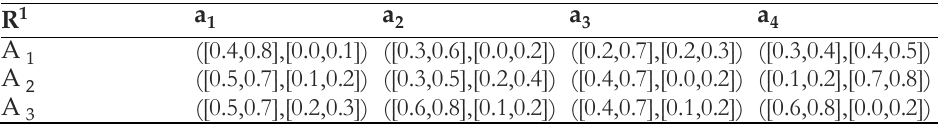
Table 1. Assesses of expert 𝐩